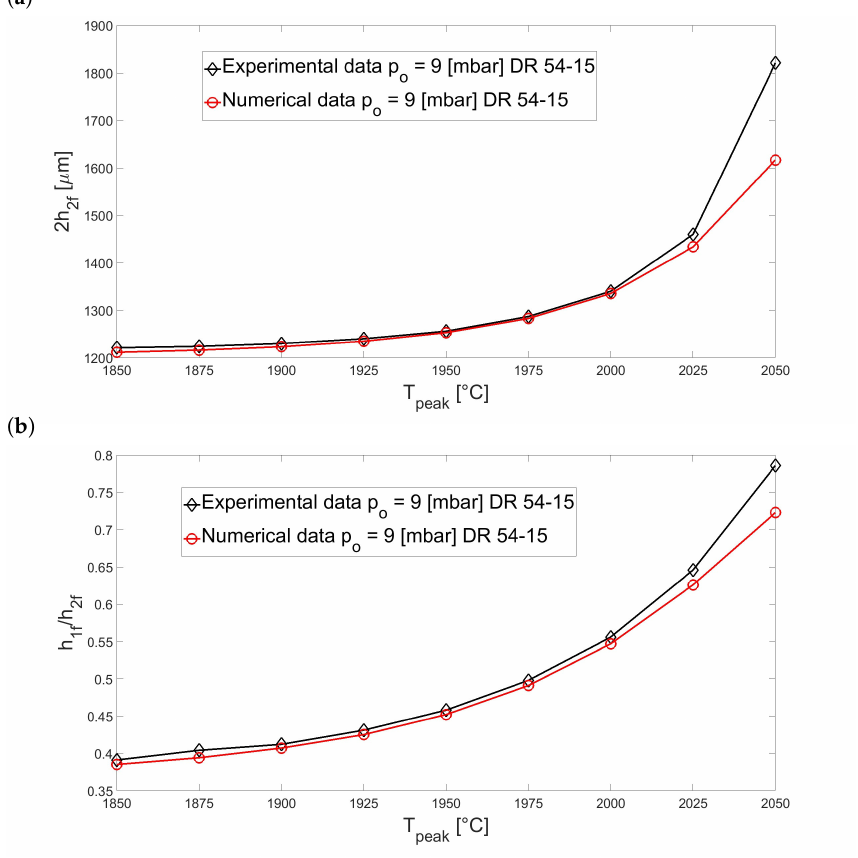
Figure 7. Comparison between the final outer diameter ( a ) and air-filling fraction ( b ) of the capillary obtained numerically and experimentally by Luzi et al. [20] for different furnace peak temperatures with a fixed value of internal